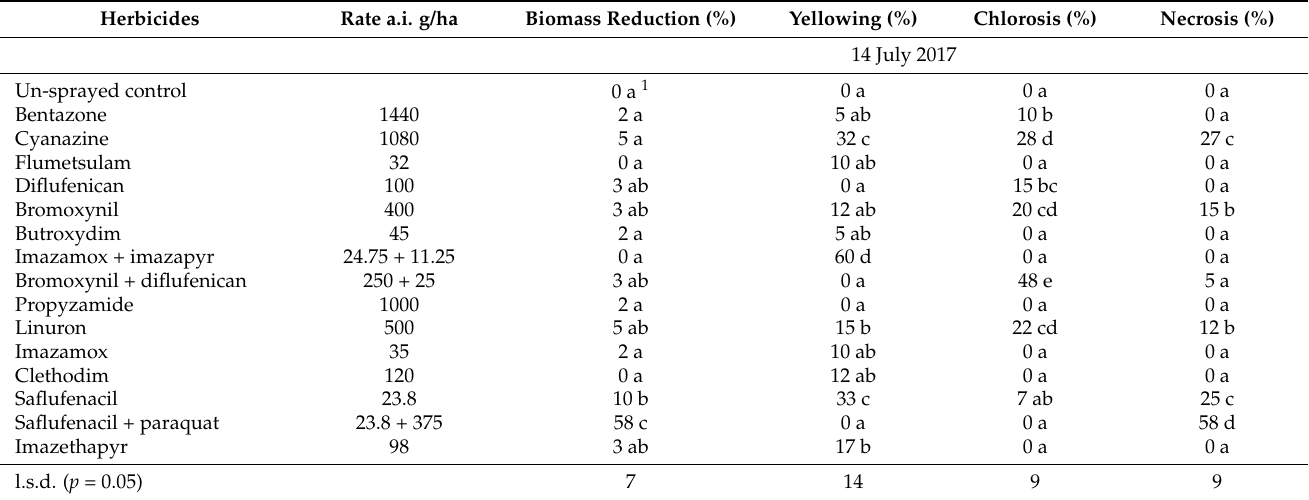
Table 5. Effect of post-emergent herbicides as visual phytotoxic symptoms (yellowing, chlorosis and/or necrosis) and biomass reduction (%) of two-year old tedera at Dandaragan. Herbicides Rate a.i. g/ha Biomass Reduction (%) Yellowing (%) Chlorosis (%) Necrosis